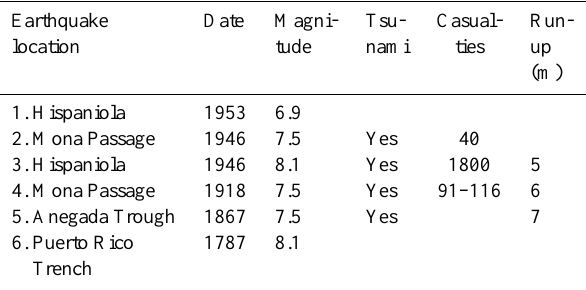
Table 1. Largest historical seismic events around Puerto Rico (USGS, 2001).